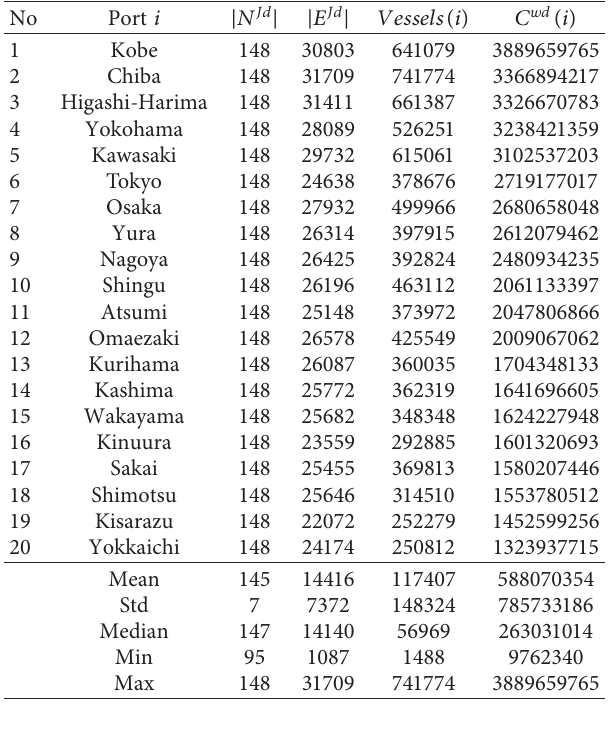
Table 4: Primary connections among the Japanese ports.